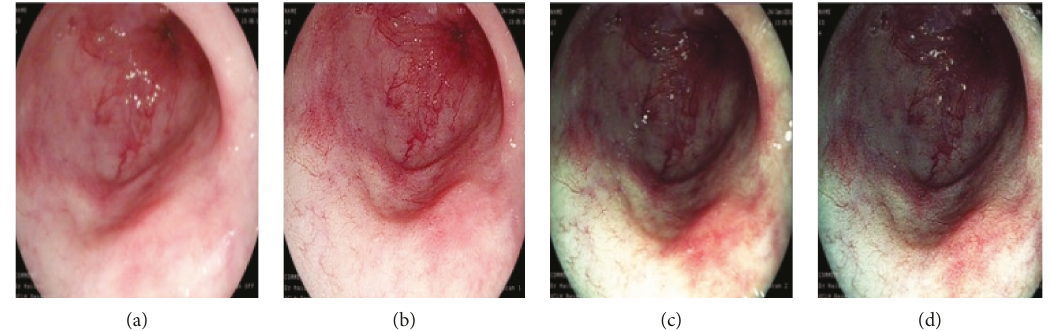
Figure 1: Endoscopic appearances of a fl at segment of nondysplastic Barrett ’ s in each separate i-Scan mode. (a) - WLE, (a) i-Scan 1, (c) i-Scan 2, and (d) i-Scan